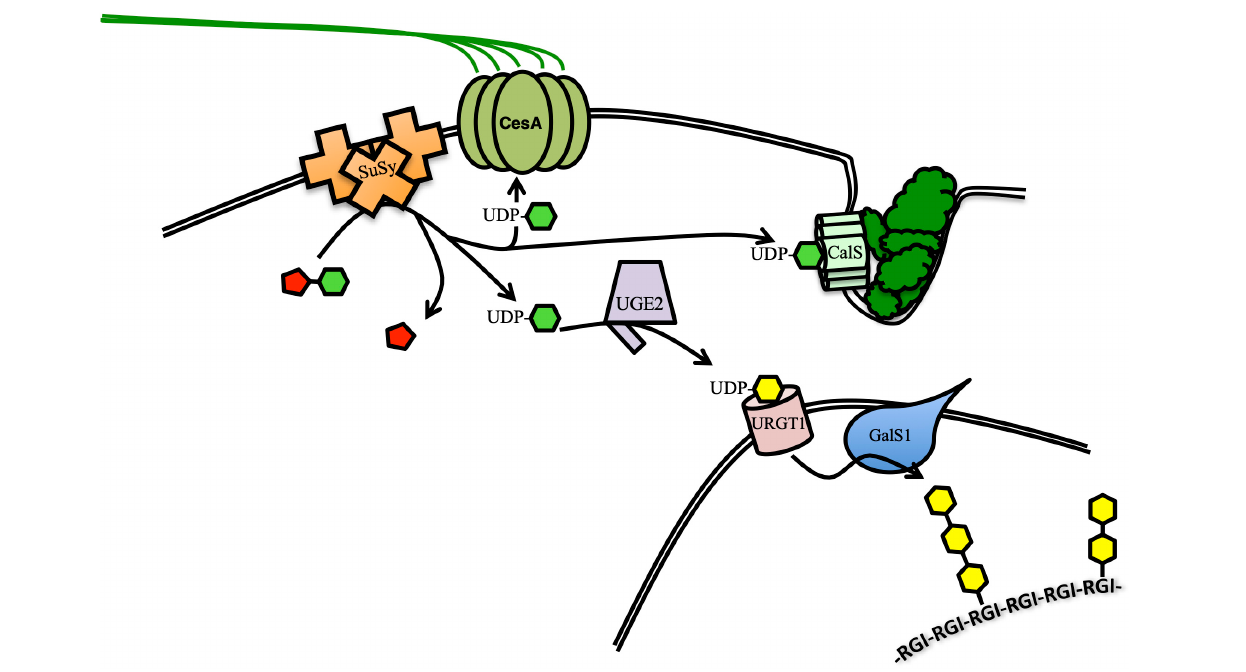
FIGURE 1 | Schematic representation of the role of sucrose synthase (SuSy) in increasing the biosynthesis of several C6-sugar polysaccharides. SuSy isoforms can be localized to the cytoplasm, or tightly associated with the plasma membrane, some interacting directly with CesA. All catalyze the reversible conversion of sucrose into fructose (red) and UDP-Glc (green). UDP-Glc is the substrate for cellulose synthesis by CesA complex or callose synthesis by CalS at the plasma membrane. UDP-Glc can also be converted to UDP-Gal (yellow) by UGE1, imported to the Golgi by URGT1, and used to synthesize the galactan side chains of pectic